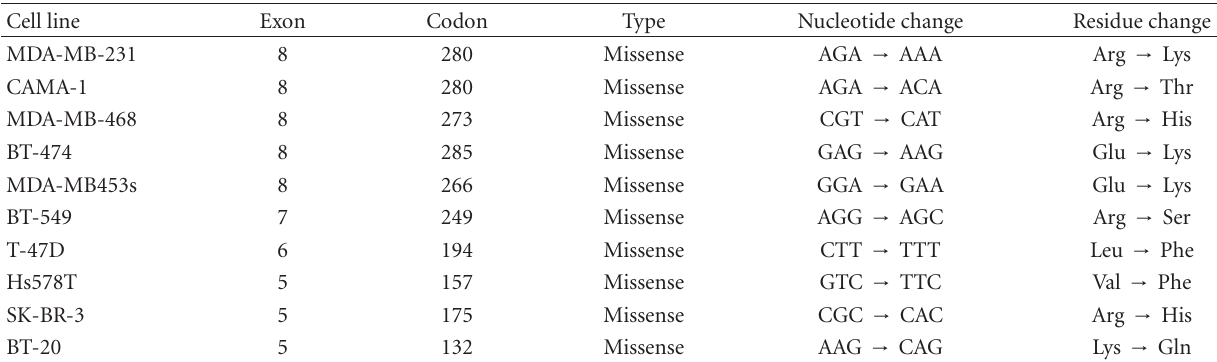
Figure 7: ATM-p53-p21 signaling in p53 wild-type human solid tumor-derived cells exposed to ionizing radiation. (a) Radiation exposure results in ATM-dependent activation of several proteins (e.g., p53, WRN, DNA-PKcs) that play important roles in DSB repair, as well as p53- mediated activation of p21 that suppresses apoptosis and activates cell cycle checkpoints. Proper activation of these early events provides time for the repair of potentially cytotoxic and mutagenic lesions. (b) Persistence of DNA damage (i.e., irreparable damage) at late times (several days) after irradiation leads to sustained induction of p21 which suppresses apoptosis and triggers SIPS. Positive feedback loops between ATM and p53 and between p53 and p21 ensure the maintenance of the SIPS response for extended times (several months in culture). WRN, Werner’s syndrome protein; DNA-PKcs, DNA-dependent protein kinase catalytic subunit; γ -H2AX, H2A variant histone H2AX phosphorylated on Ser 139. Table 1: p53 mutations in commonly used human breast cancer cell